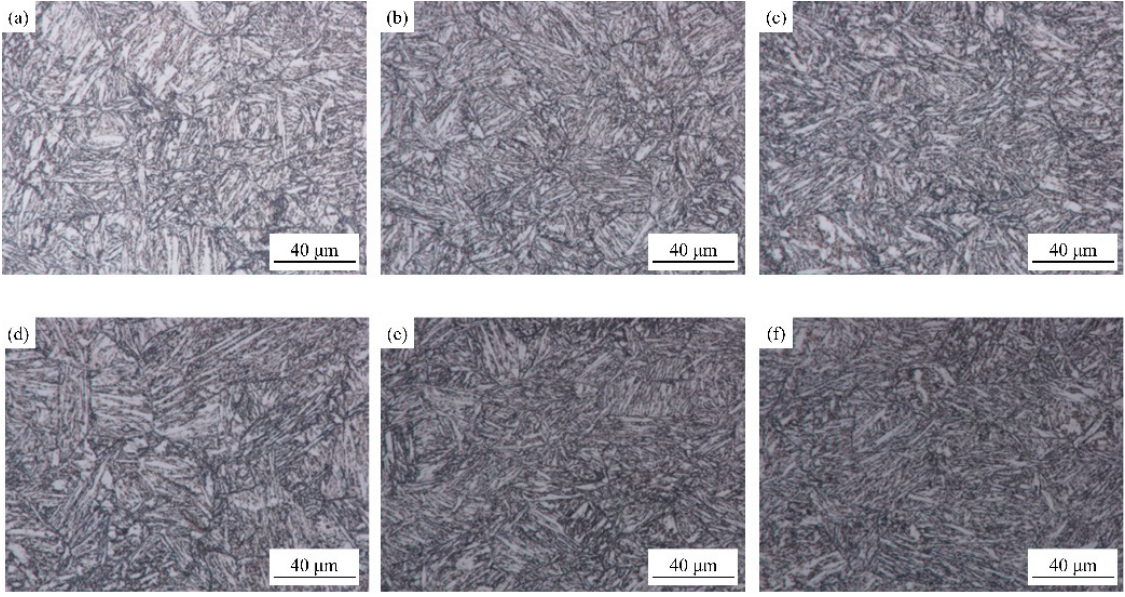
Figure 10. Optical microstructure of 0.004ZrD ( a – c ) and 0.004ZrH ( d – f ) aged for different times ( a , d ) 500 h, ( b , e ) 1000 h, and ( c , f ) 1500 h.